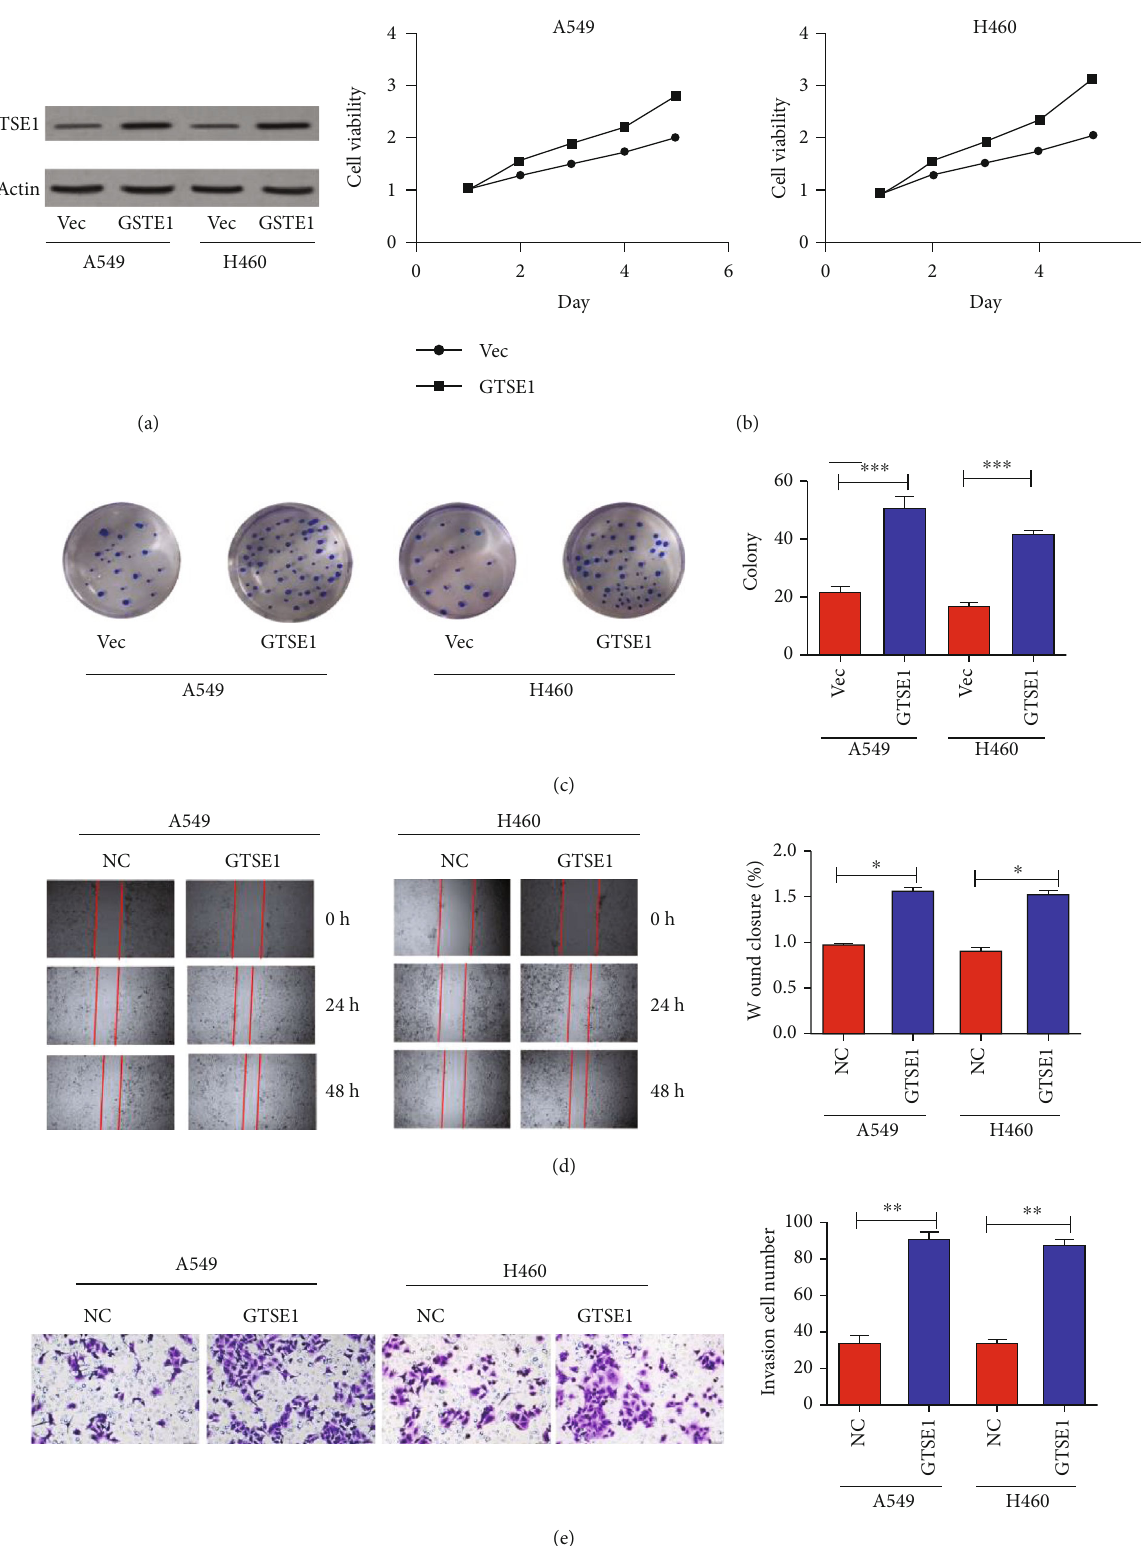
Figure 3: Ectopic expression of GTSE1 promotes proliferation, migration, and invasion of lung cancer cells A549 and H460. (a – e) GTSE1 was overexpressed in A549 and H460 cells. (a) The overexpression of GTSE1 in cells A549 and H460 was validated by using the WB assay. The CCK8 assay (b), colony formation (c), wound healing assay (d), and transwell invasion assay (e) were performed to evaluate cell proliferation, migration, and invasion. ∗ p < 0 : 05 and ∗∗ p < 0 : 01